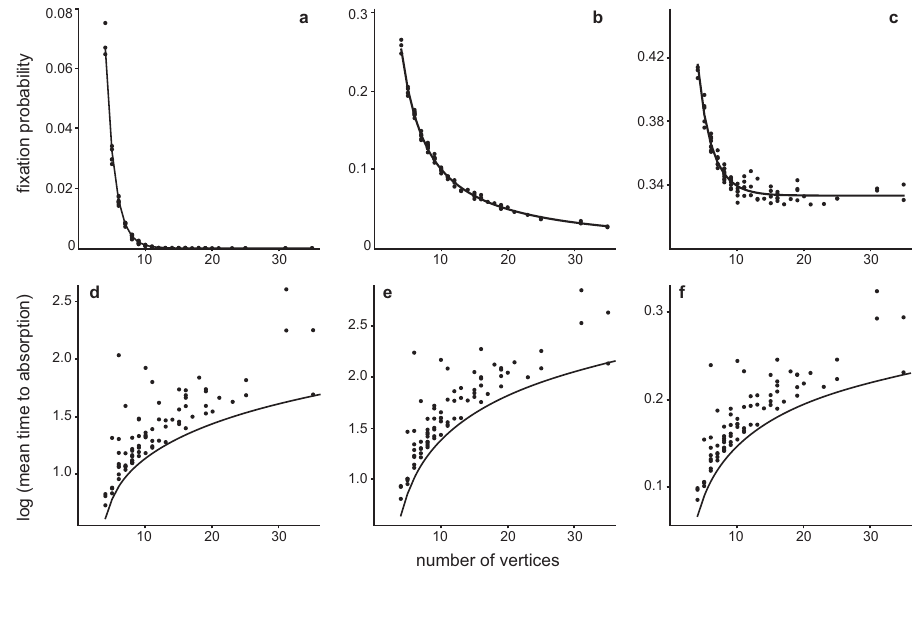
Figure 2. Fixation probabilities and mean times to absorption for the fixed fitness case. The resident strategy has a fitness of 1 and the mutant has a fitness of r with (a, d) r = 0.5, (b, e) r = 1.0, (c, f) r = 1.5. Dots give mean values for 10,000 simulations for each of the 81 primate graphs and the solid line gives the expected value for a well mixed